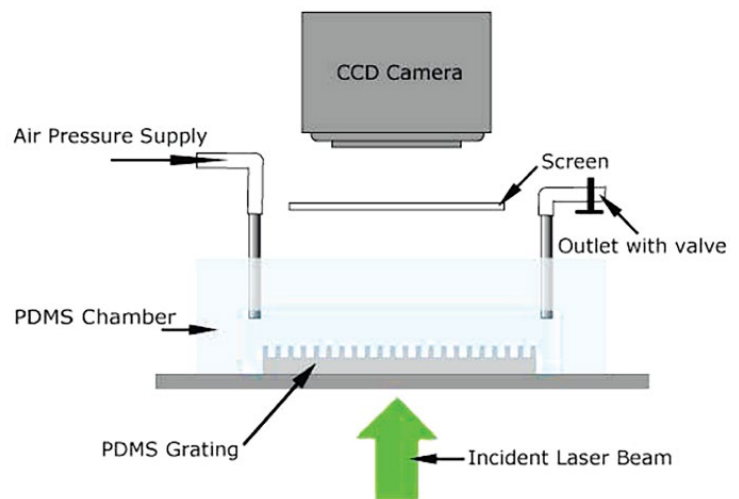
Figure 10. Schematic diagram of the experimental setup for the pressure-dependent observation of diffraction patterns of the water-submerged superhydrophobic grating. Reprinted with permission from Ref. [82]. Copyright@2010, Langmuir.